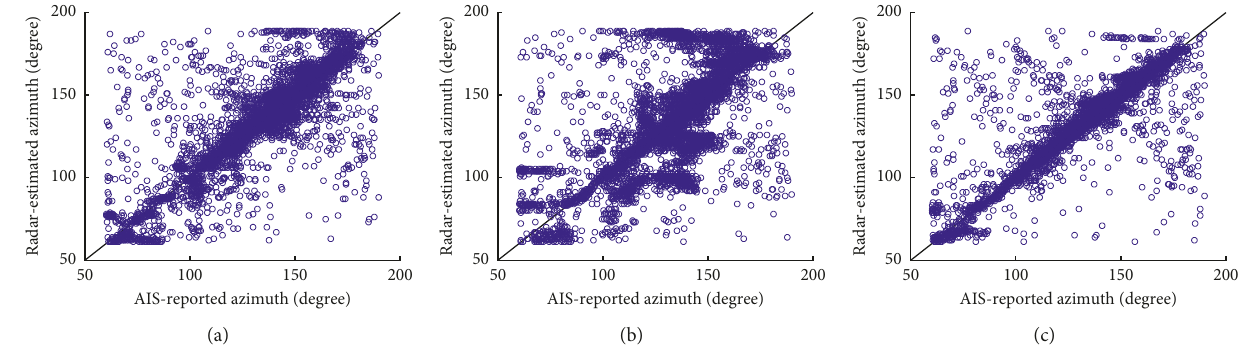
Figure 5: DOA estimation results in Longhai. (a) Antenna-1. (b) Antenna-2. (c) Dual antenna array. Table 1: Statistics of DOA estimation results.